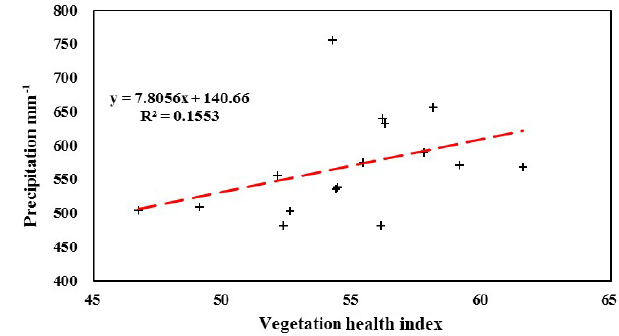
Figure 10. Correlationship between crop yield and the VHI during 2000–2015 in the Wei River Basin.